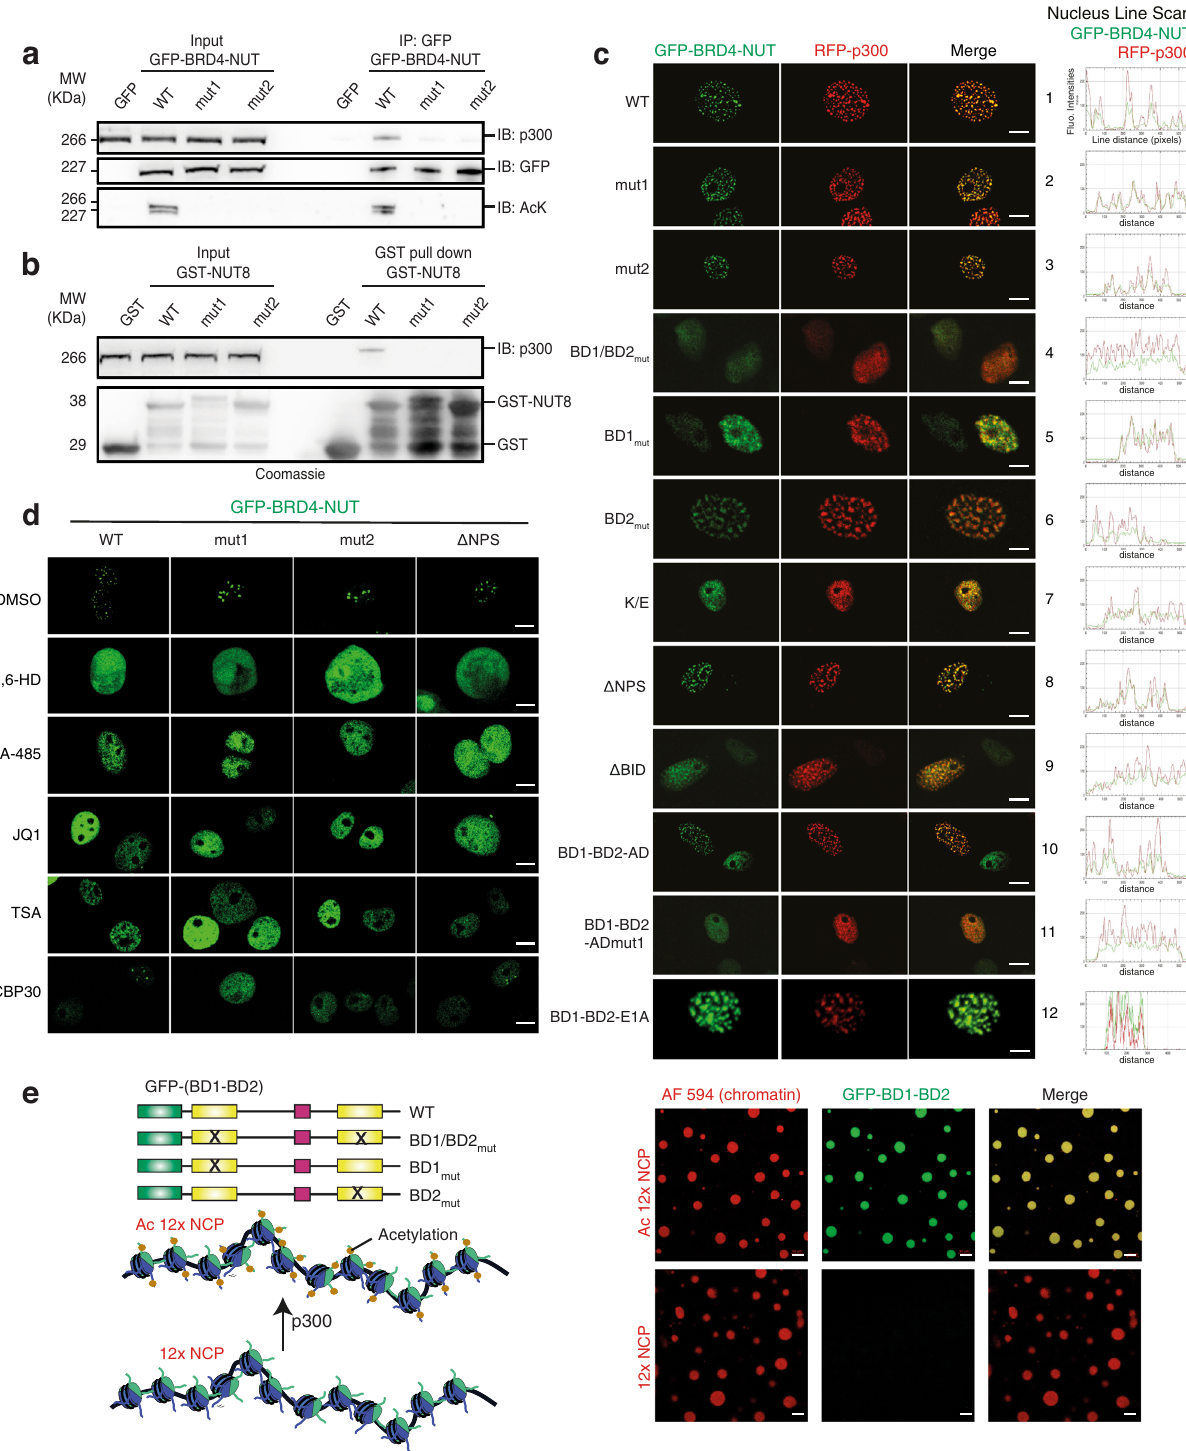
Fig. 4 | RoleoftheTAZ2domain in p300regulationand substrate acetylation. a AlphaFold prediction of p300 core-CH3 (1048-1838) structure. The structure is colouredaccordingtodomainstructure.TheTAZ2domainispositionedintheHAT activesitethusautoinhibitingsubstrate access.TheTAZ2C-terminalhelixdeletion ( Δ 1813-1838) iscoloured in magenta b NUTADbinding displaces the TAZ2domain fromtheHATactivesitethusenablingallostericHATactivation. c p300sor d ,p300 core were incubated with [ 14 C]Acetyl-CoA in the presence or absence (C: p300 alone) of increasing concentrations of wild type or mut1 NUT8 (396-470). e Increasing concentrations of GST-E1a we incubated with p300s. f Increasing